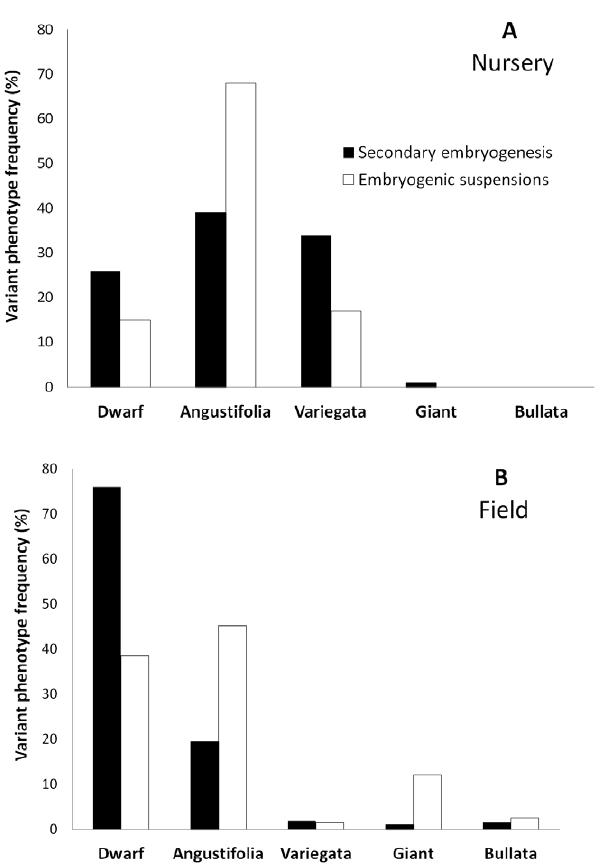
Figure 2. Proportions (%) of the different types of phenotypic variants in comparison to the total number of variants. Variants representing less than 1% of somatic embryogenesis-derived plants were observed in C. arabica embling batches at nursery (A) and field (B) levels, depending on the proliferation system used, i.e. secondary embryogenesis (SCE) or embryogenic suspension (ESP). In the nursery, the data were obtained from 239 009 emblings derived from SCE and 402 576 emblings from ESP. In the field, the data were obtained through the observation of 100 257 emblings derived from secondary embryogenesis and 108 784 from embryogenic suspensions.